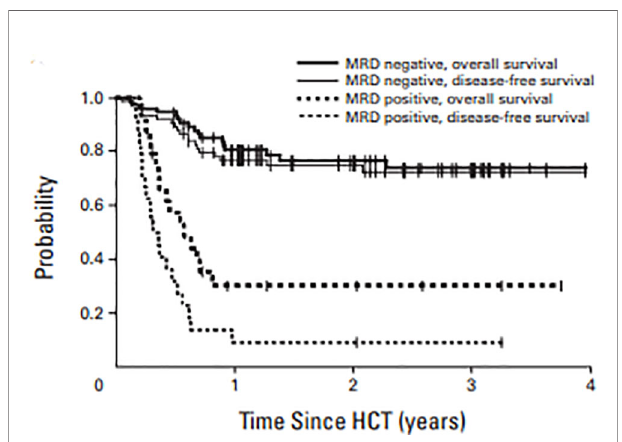
FIGURE 8 | OS and DFS in AML patients in morphologic remission based on MRD by MPFC assessment in pre transplant marrow.